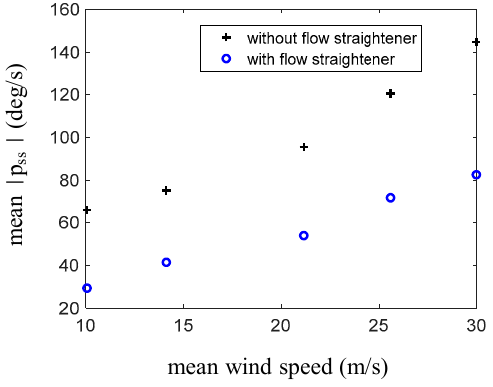
Figure 15. Mean steady state roll rate with and without flow straightener.